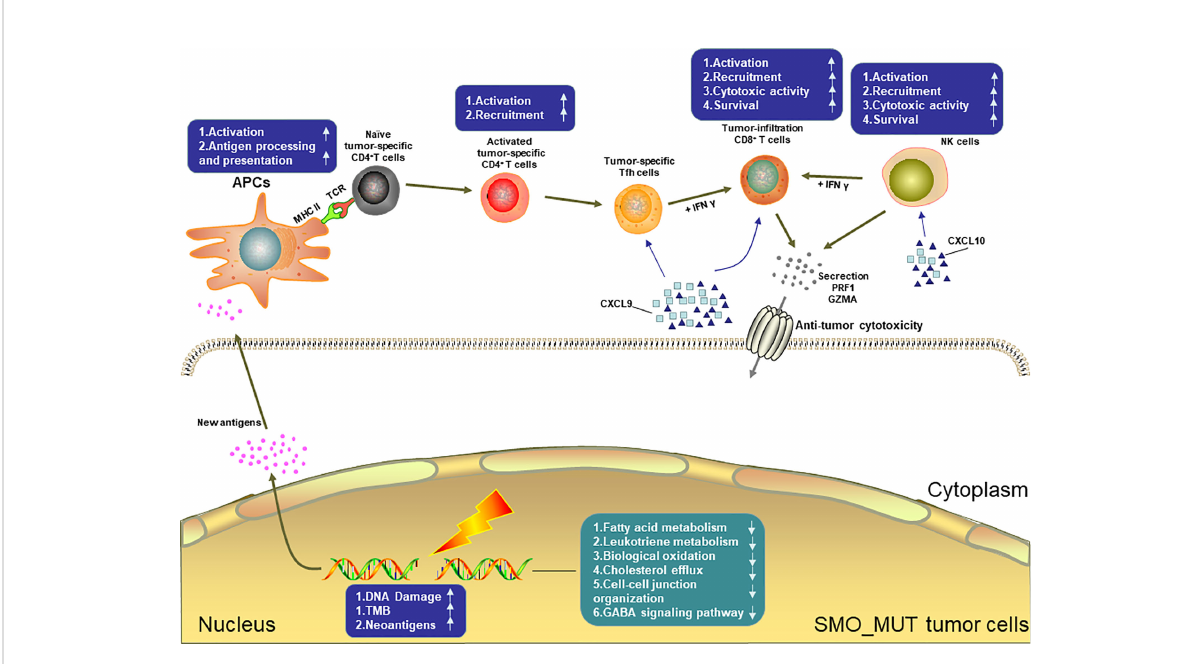
FIGURE 8 Possible tumor immune microenvironment in SMO mutant tumors. APCs , antigen-presenting cells; NK cell, natural killer